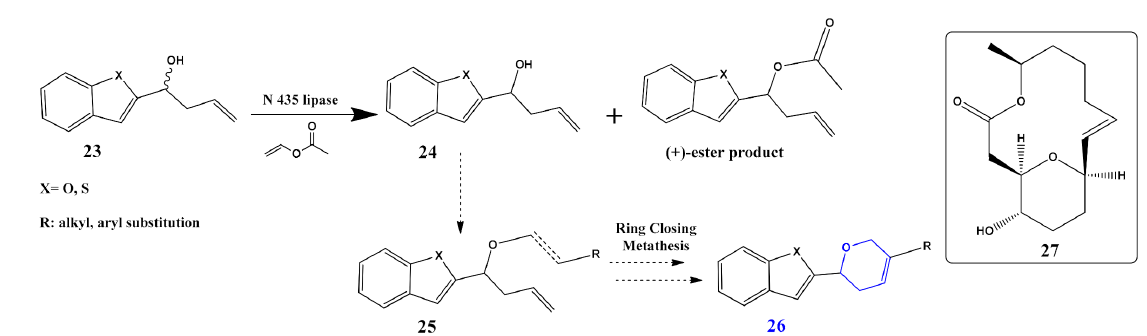
Scheme 7. N 435 lipase catalyzed chiral homoallylic alcohol